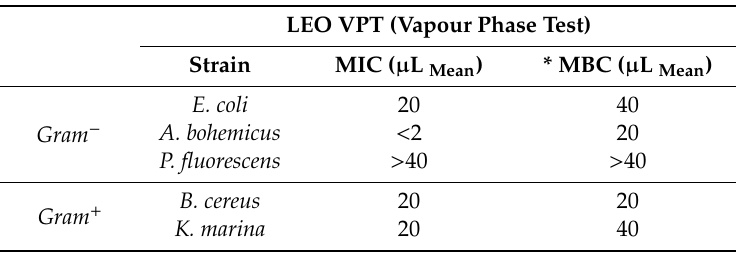
Table 5. LEO vapour phase test showing minimum inhibitory concentration (MIC) and minimum bactericidal concentration means (MBC) expressed in µ L against the five bacteria